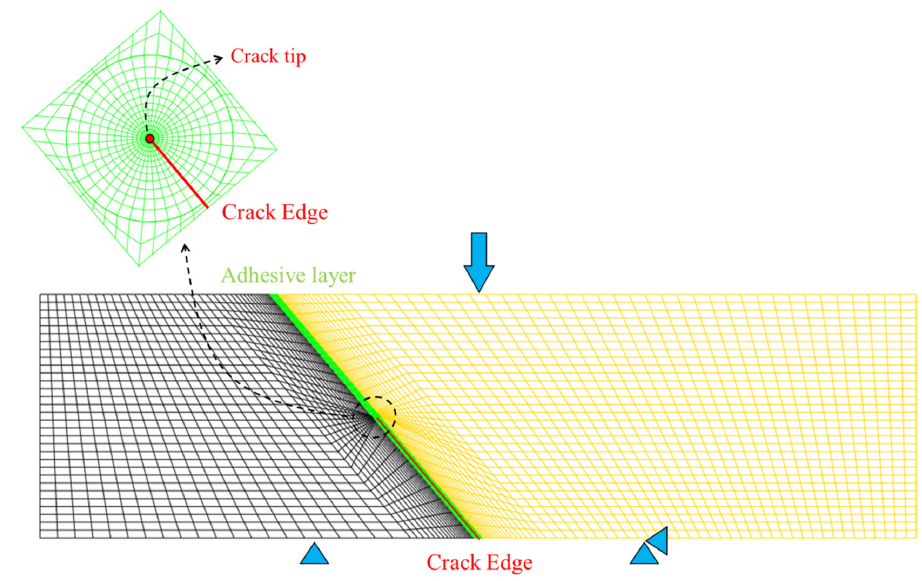
Figure 2. Finite element model of BISBB specimen.